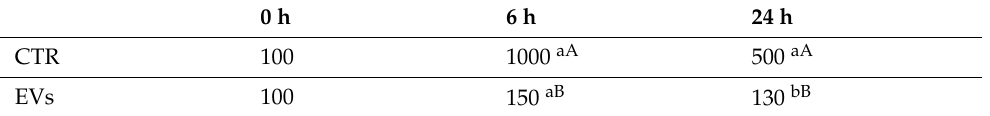
Table 4. Value in mm 2 of intrauterine fluid evaluated in the control and treated mares.